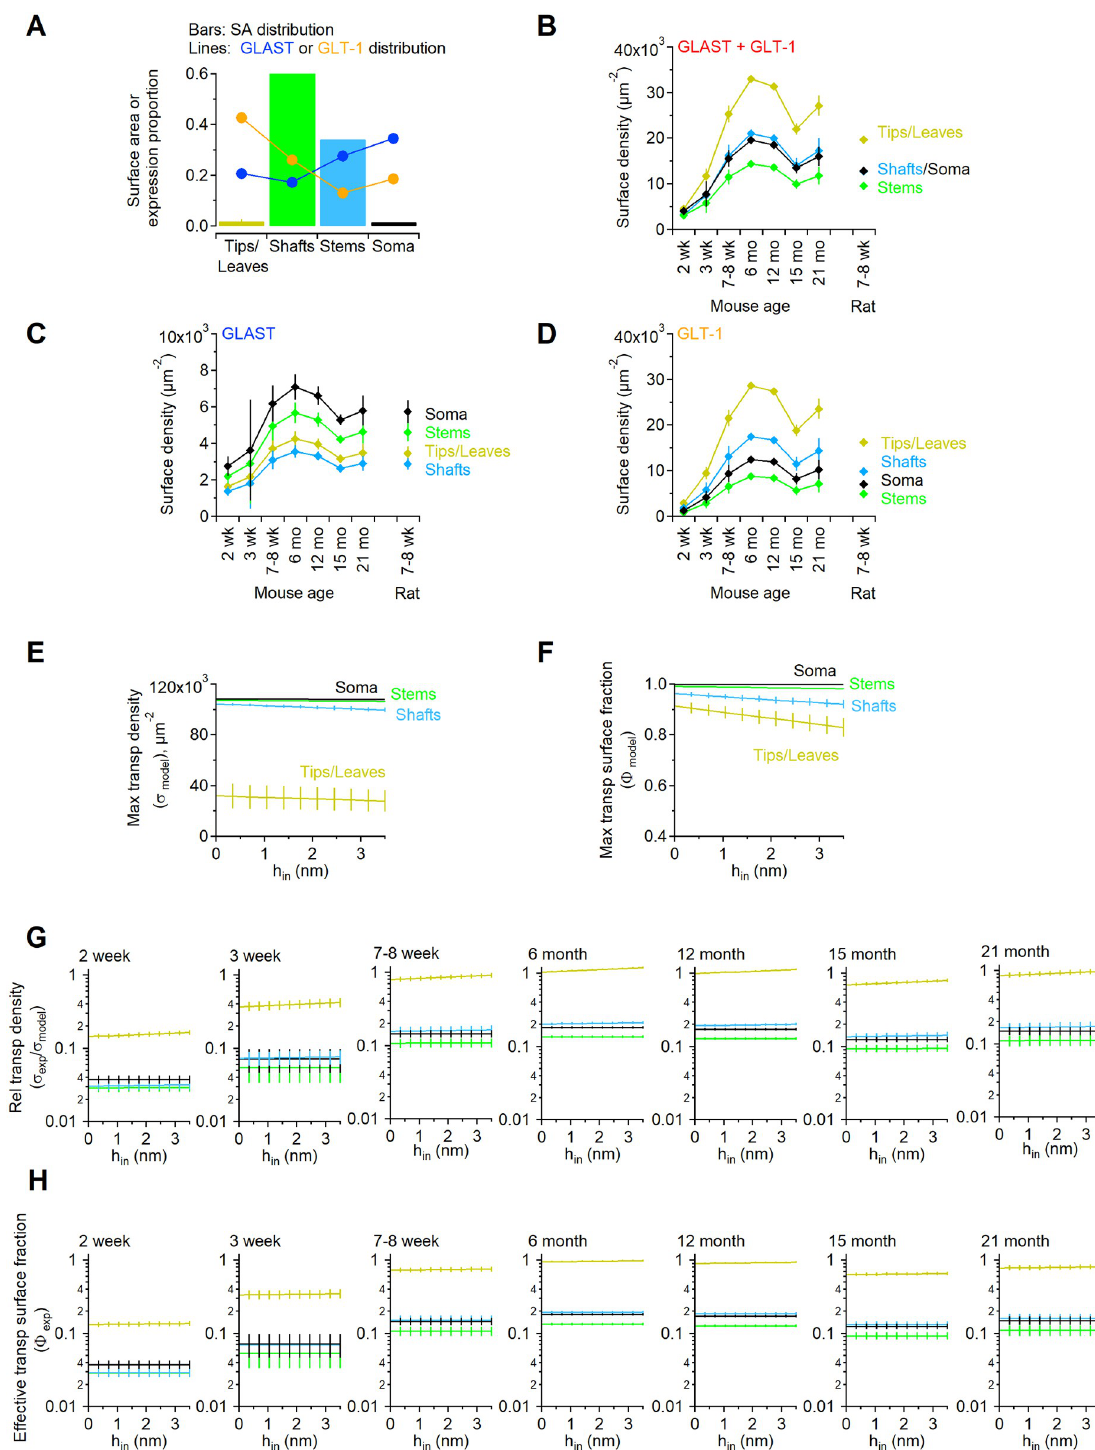
Fig 5. Spatial gradient of glutamate transporter expression in different sub-cellular compartments. A . The color-coded bar graphs represent the surface area distribution in four different astrocyte sub-cellular compartments. The tips and leaves represent the hemispheric endings of the terminal branches, and the thin protrusions that depart from all astrocyte branches, respectively. The stems represent the sum of primary and secondary branches. The soma represents the surface area of a spherical representation of the soma following subtraction of the surface area of the sphere underlying the base of the primary branches. The shafts represent all other compartments that